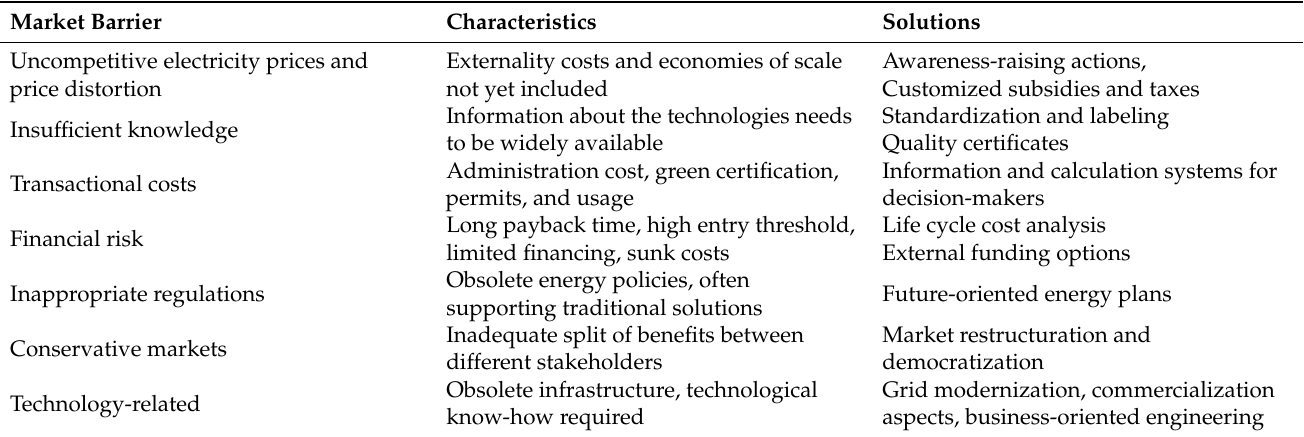
Table 1. Examples of market barriers to RET diffusion. Developed based on